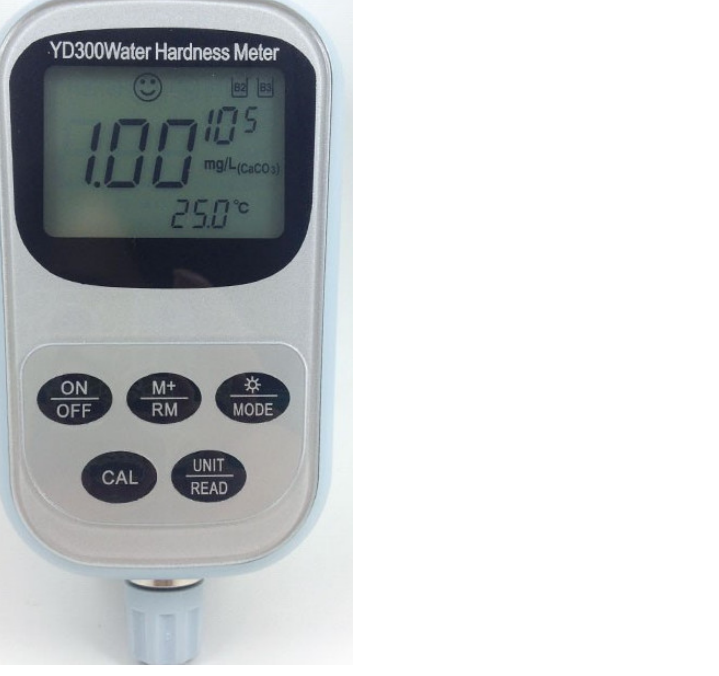
Figure 9. Portable groundwater calcium ion concentration detector.